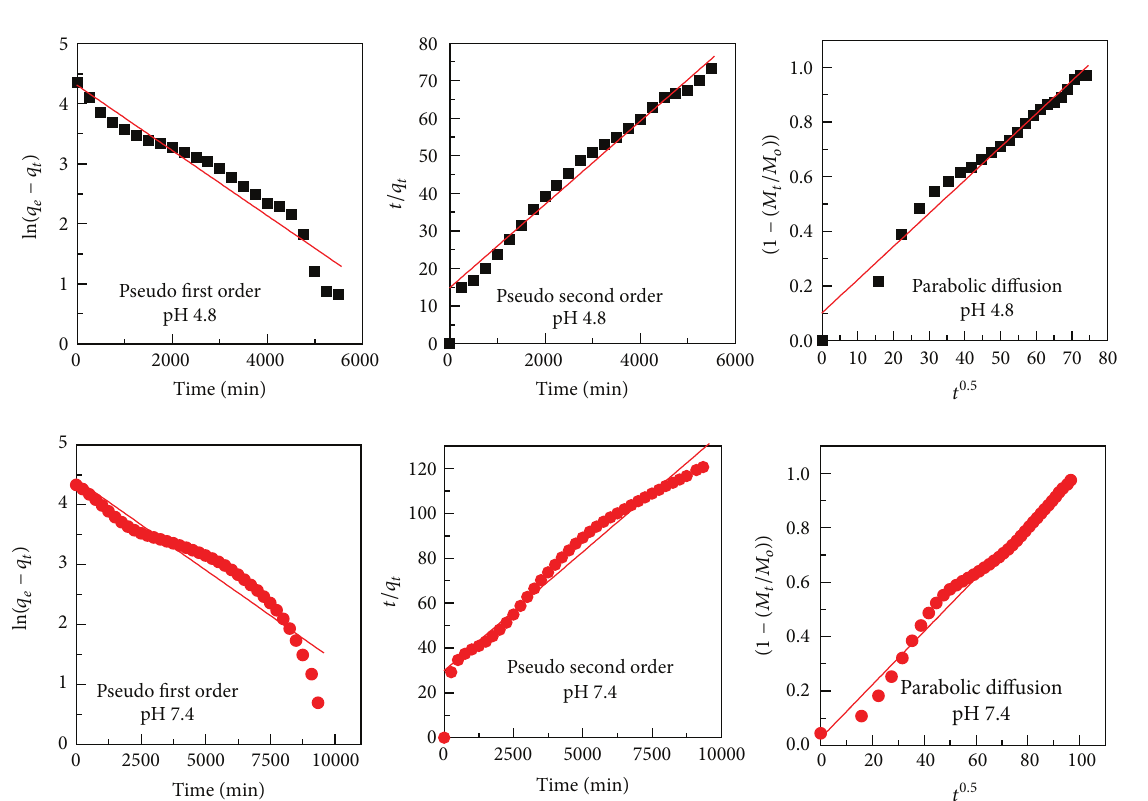
Figure 8: Fits for the dopa release data from Tween-dopa-LDH nanocomposite to the pseudo-first- and second-order kinetics models as well as to the parabolic diffusion model at pH 7.4 and